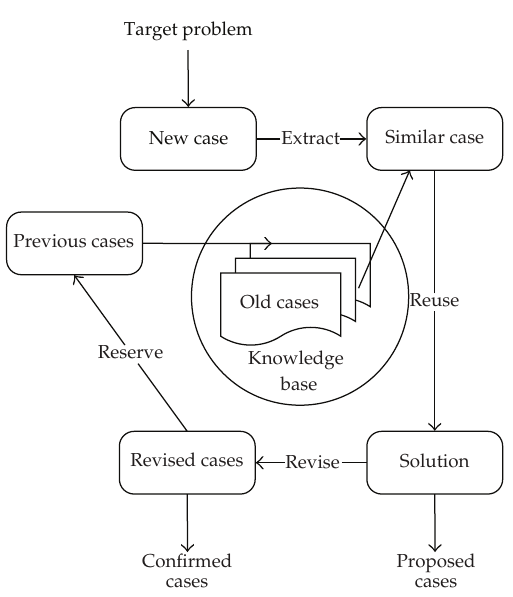
Figure 1: Process of general case-based